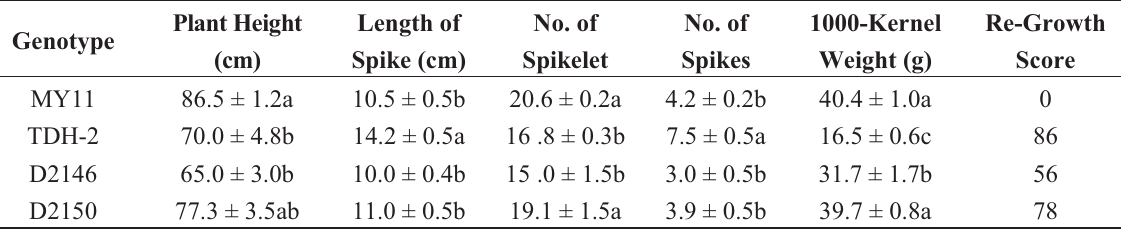
Table 2. Agronomical traits of wheat— D. breviaristatum 5V b derivatives.